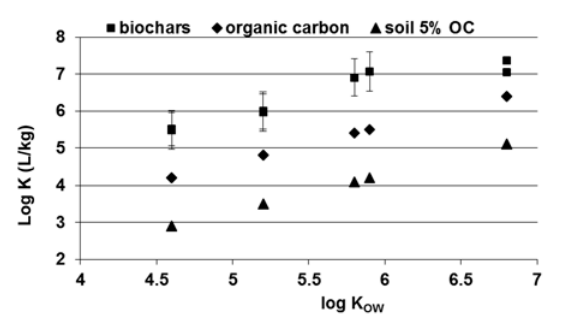
Fig. 1. Sorption (expressed as logarithmic solid-water distribution coefficients, K) to 21 biochars (average and standard deviation), organic carbon (without black carbon) and an examplary soil containing 5% of this organic carbon, as a function of PAH hydrophobicity expressed as octanol–water partition constant (log K ) (source: Cornelissen et al. 2017) OW